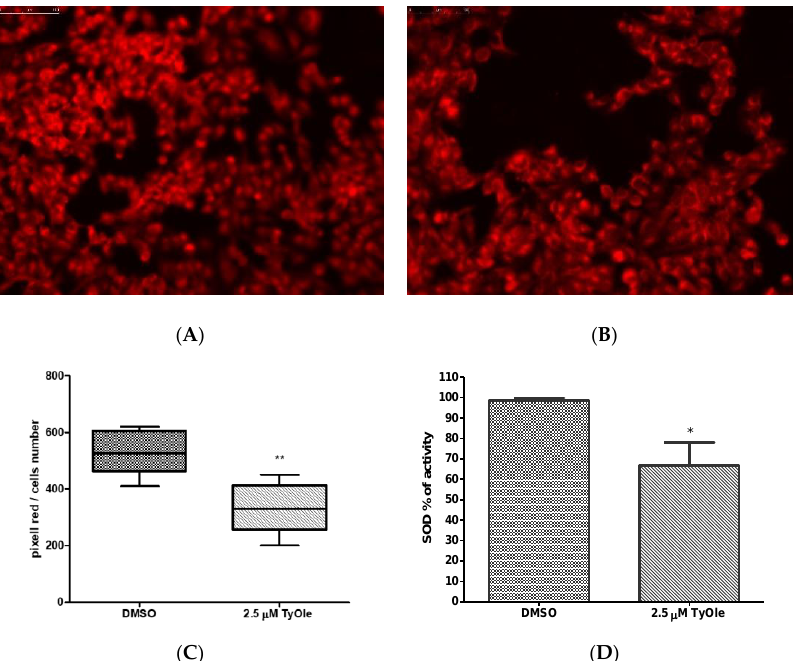
Figure 5. Mitochondrial ROS staining in human keratinocytes treated with vehicle (DMSO) ( A ) or 2.5 µM of tyrosyl oleate (TyOle) ( B ). Pixels for red stained keratinocytes ( C ). Enzymatic activity of